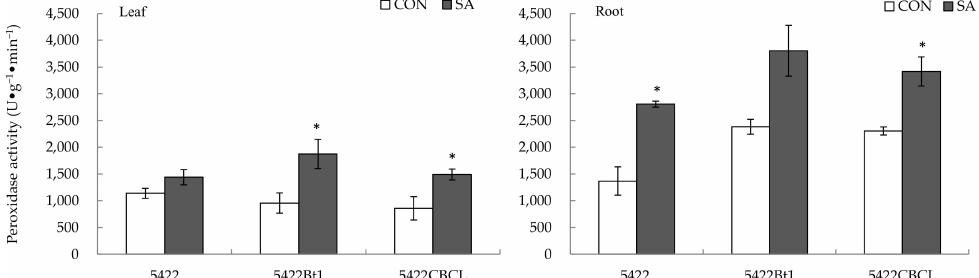
Figure 5. Direct and systemic effects of exogenous salicylic acid application to the aboveground part on the activity of peroxidase in the leaves and roots of conventional and Bt corns. The data in the figure are means ± standard errors. Significance among the data was determined by paired Student’s t -test. “*” showed p < 0.05. CON: control; SA: salicylic acid.